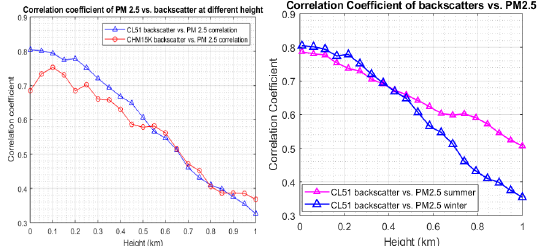
Figure 4. Left: Correlation as function of height between backscatter from two ceilometers and surface PM2.5 concentrations. Right: Correlation as function of height between backscatter from CL51 and surface PM2.5 concentrations in winter and